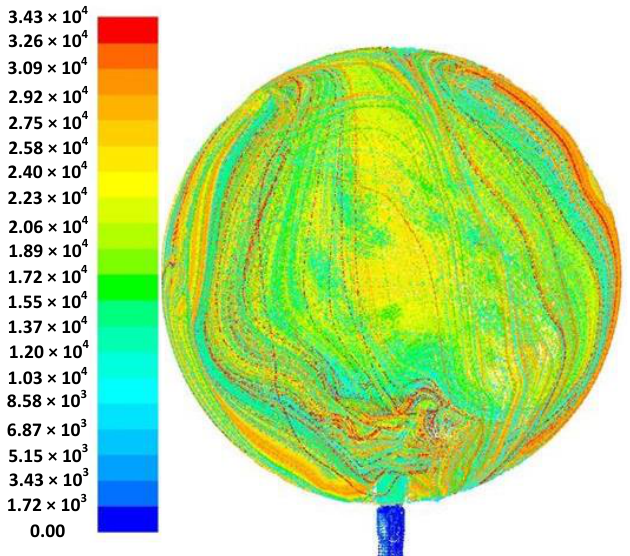
Figure 9. Traces of dust activity before ignition and explosion.